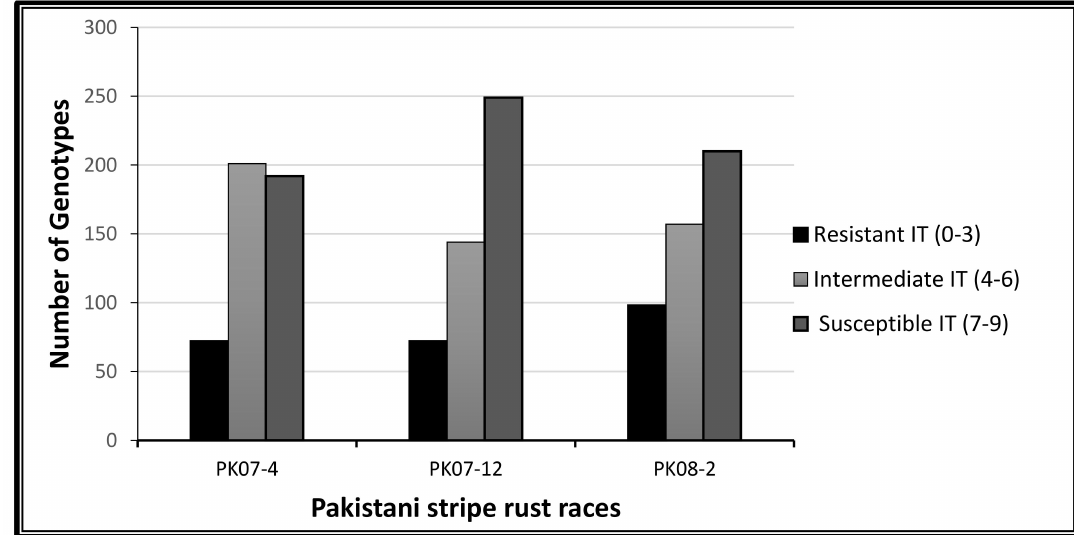
Figure 2. Infection distribution of the 465 spring wheat genotypes at the seedling stage based on their infection type (IT) score, tested with three stripe rust races from